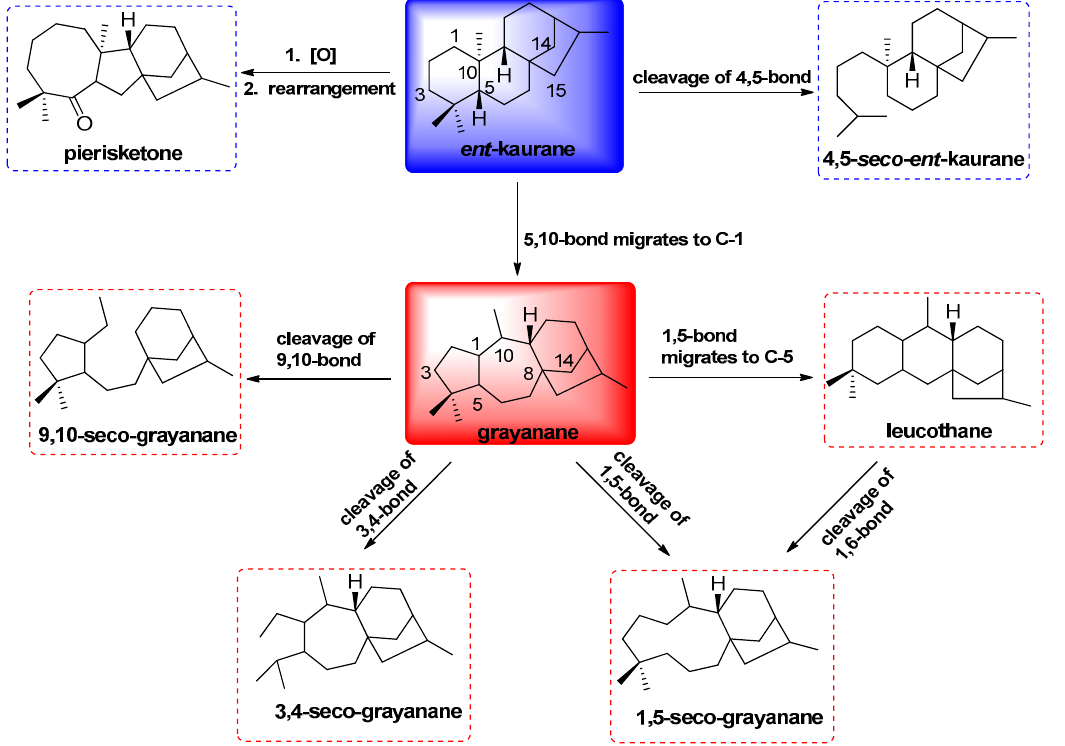
Figure 1. Biogenetic relationships of grayanane carbon skeletons from the genus Pieris .